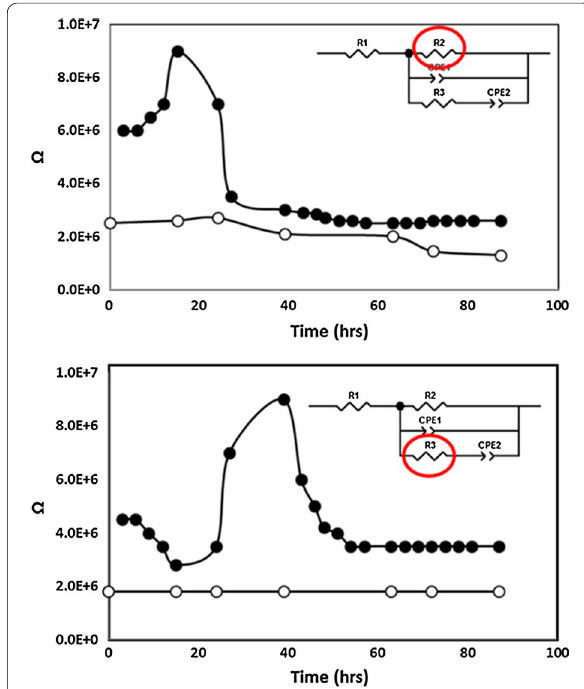
Fig. 6 The equivalent circuit used was in good agreement with the experimental data and provided information related to changes in R2 (top), ascribed to ionic flux across bacterial membranes and R3 (bottom), ascribed to metabolic activity and growth of C. phytofermentans (black circles) relative to abiotic controls (white